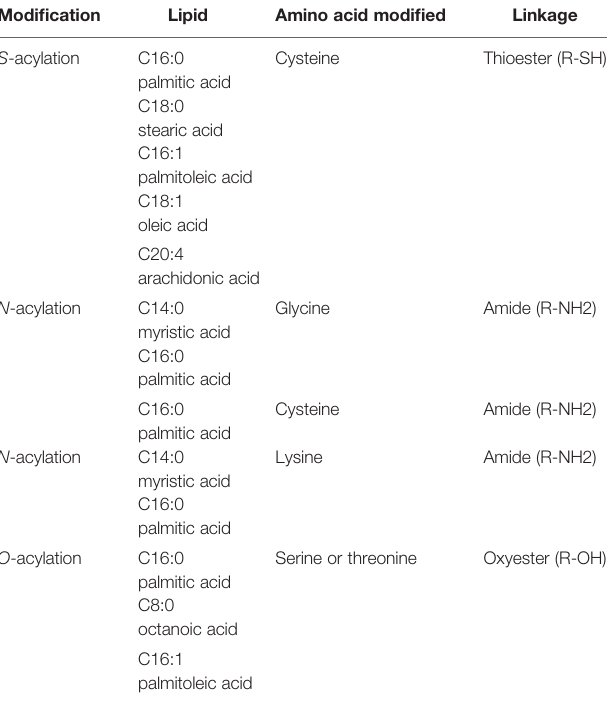
TABLE 1 | Fatty acylation of proteins.